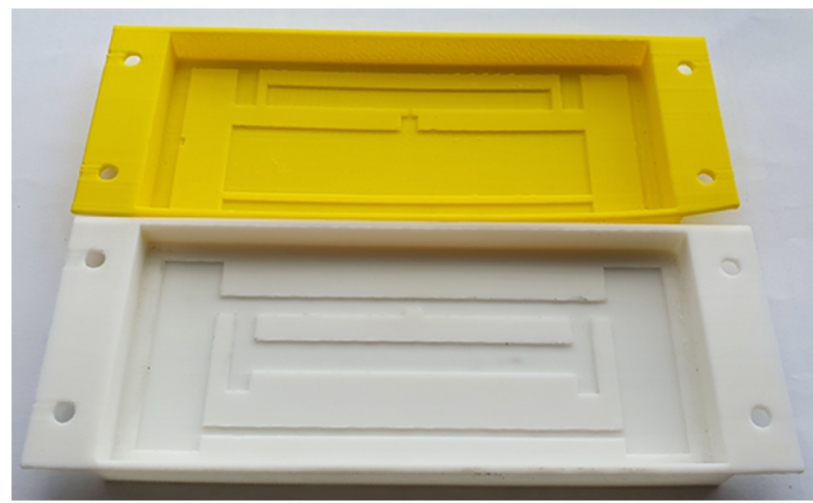
Figure 1. Yellow PLA convex and white ABS concave 3D cavity antenna structure.